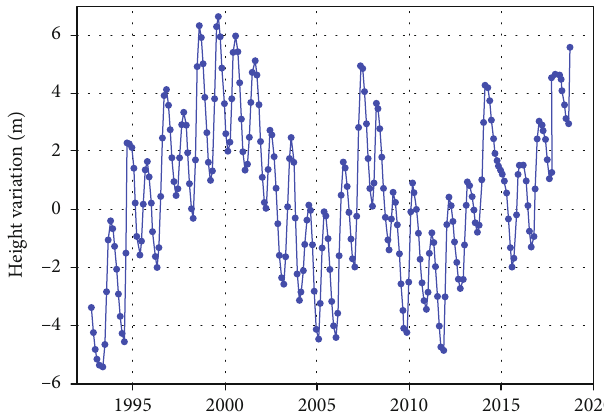
Figure 4: Variation of the Lake Nasser water levels from 1992 to 2018 [15].